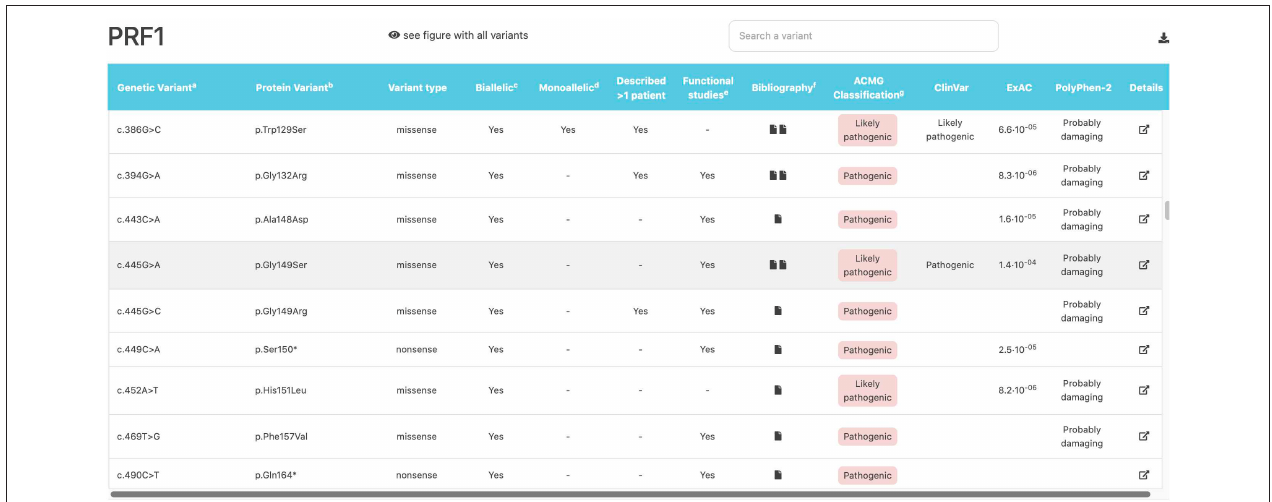
FIGURE 4 | Example of the gene view page where all variants are listed and their main characteristics described. The PRF1 gene view page is shown. The variant indicated by the pointer is highlighted in gray (in this example, c.445G > A).